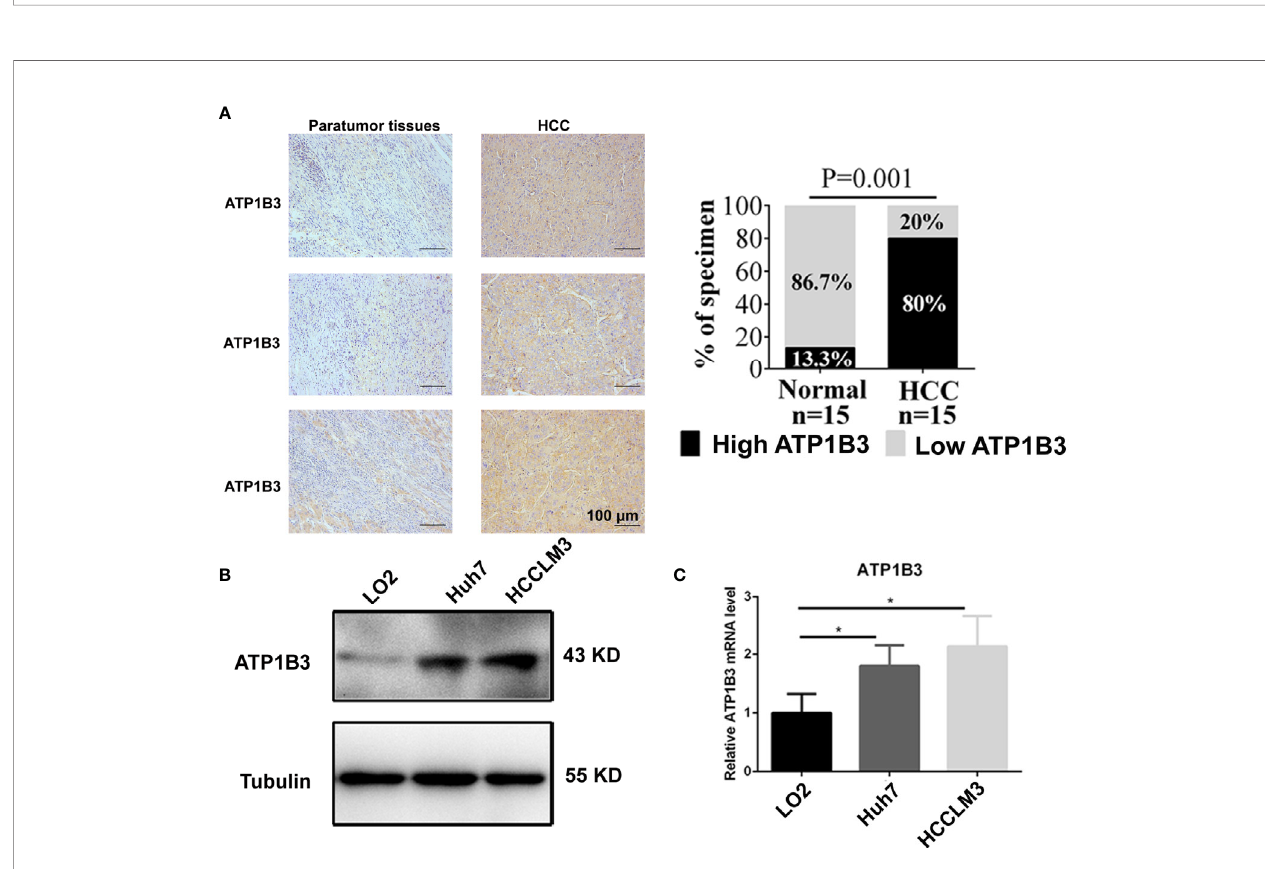
FIGURE 9 | ATP1B3 expression in the HCC cells and HCC tissues. (A) The protein levels of ATP1B3 in HCC tissues and paratumor tissues were detected by IHC. Scale bars= 100 m m. (B) The protein expression level of ATP1B3 in HCC cells and normal liver cell were detected by Western Blot. (C) The mRNA expression level of ATP1B3 in HCC cells and normal liver cell were detected by qPCR. * p <